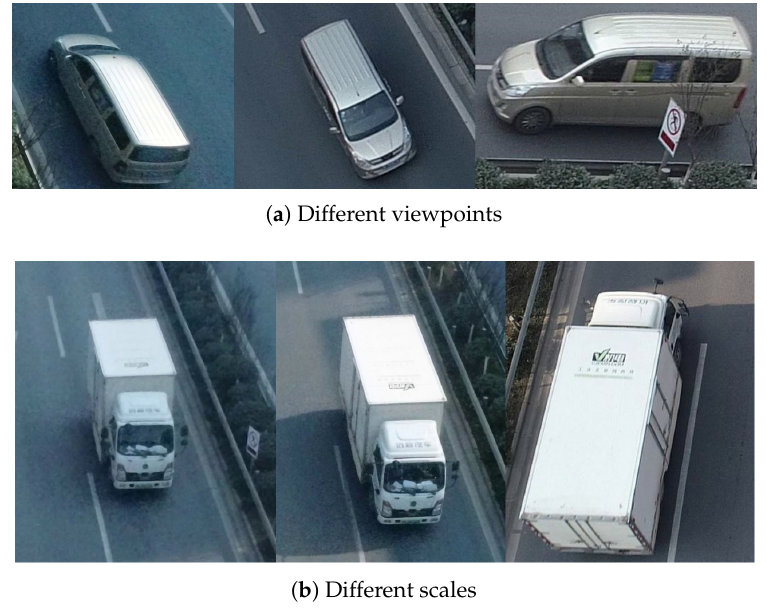
Figure 2. Images in VRU with different viewpoints and